Question: Does the plotted quantity increase or decrease?
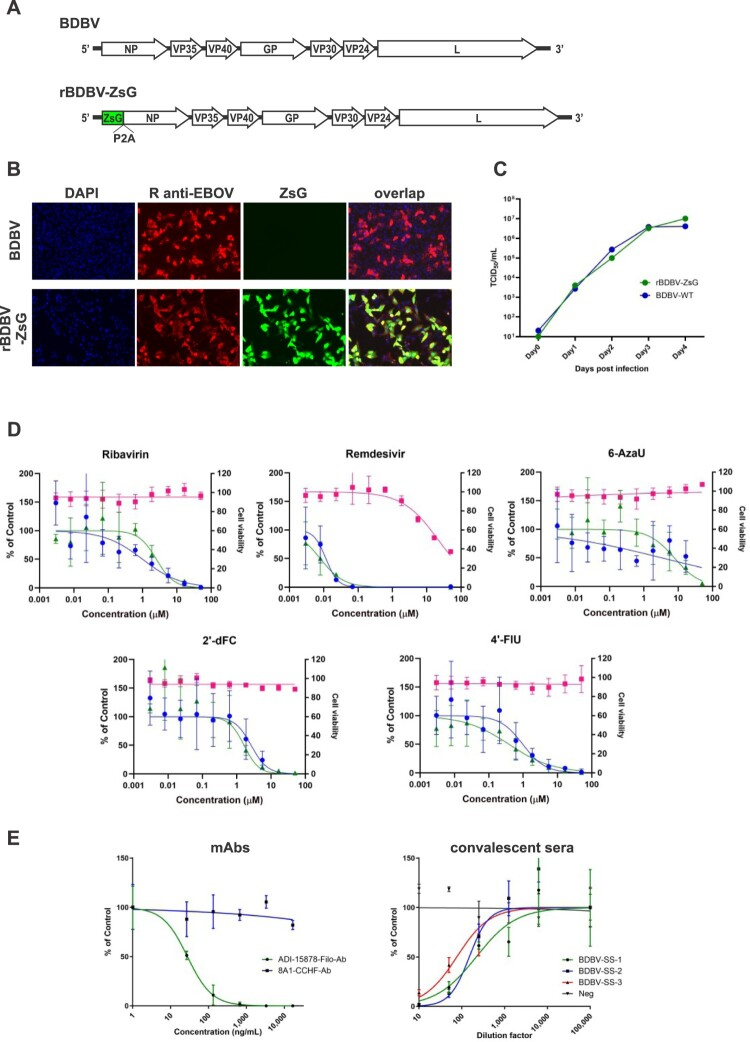
Answer: increasing